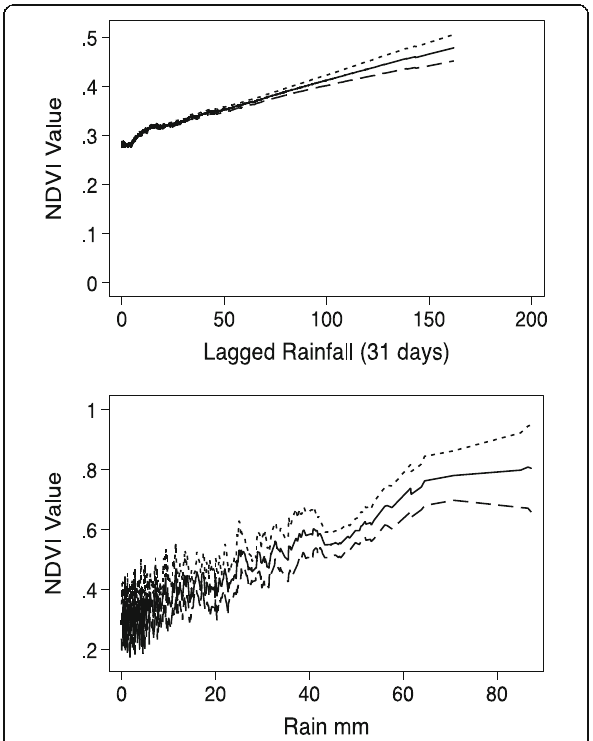
Figure 10 Symmetric nearest neighbour locally weighted regression of NDVI as a function of rainfall (mm) ( p <